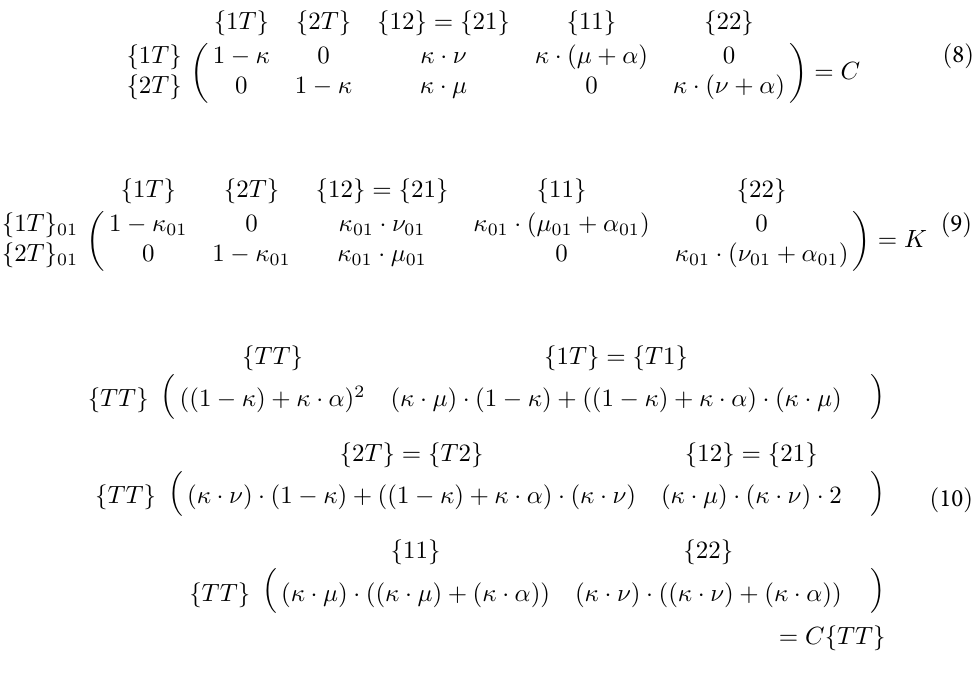
S1 Fig. Overview of the genotype conversion process that repeats each generation. (a) Illus- tration of the different stages of the model. (b) Names of the symbols used in a. Each genotype conversion step is expanded upon in the